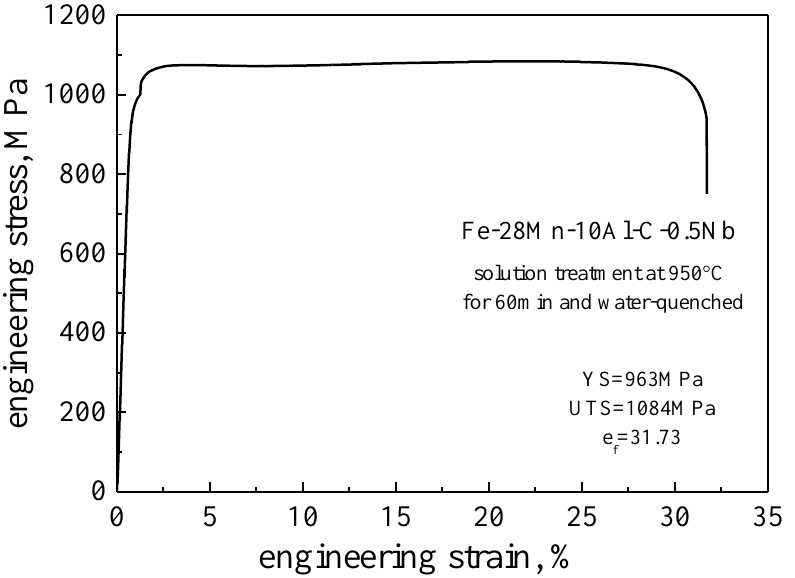
Figure 7. Engineering stress-strain curves of Fe–28Mn–10Al–C–0.5Nb low-density steel tested at room temperature at an initial strain rate of 1 × 10 − 3 s − 1.